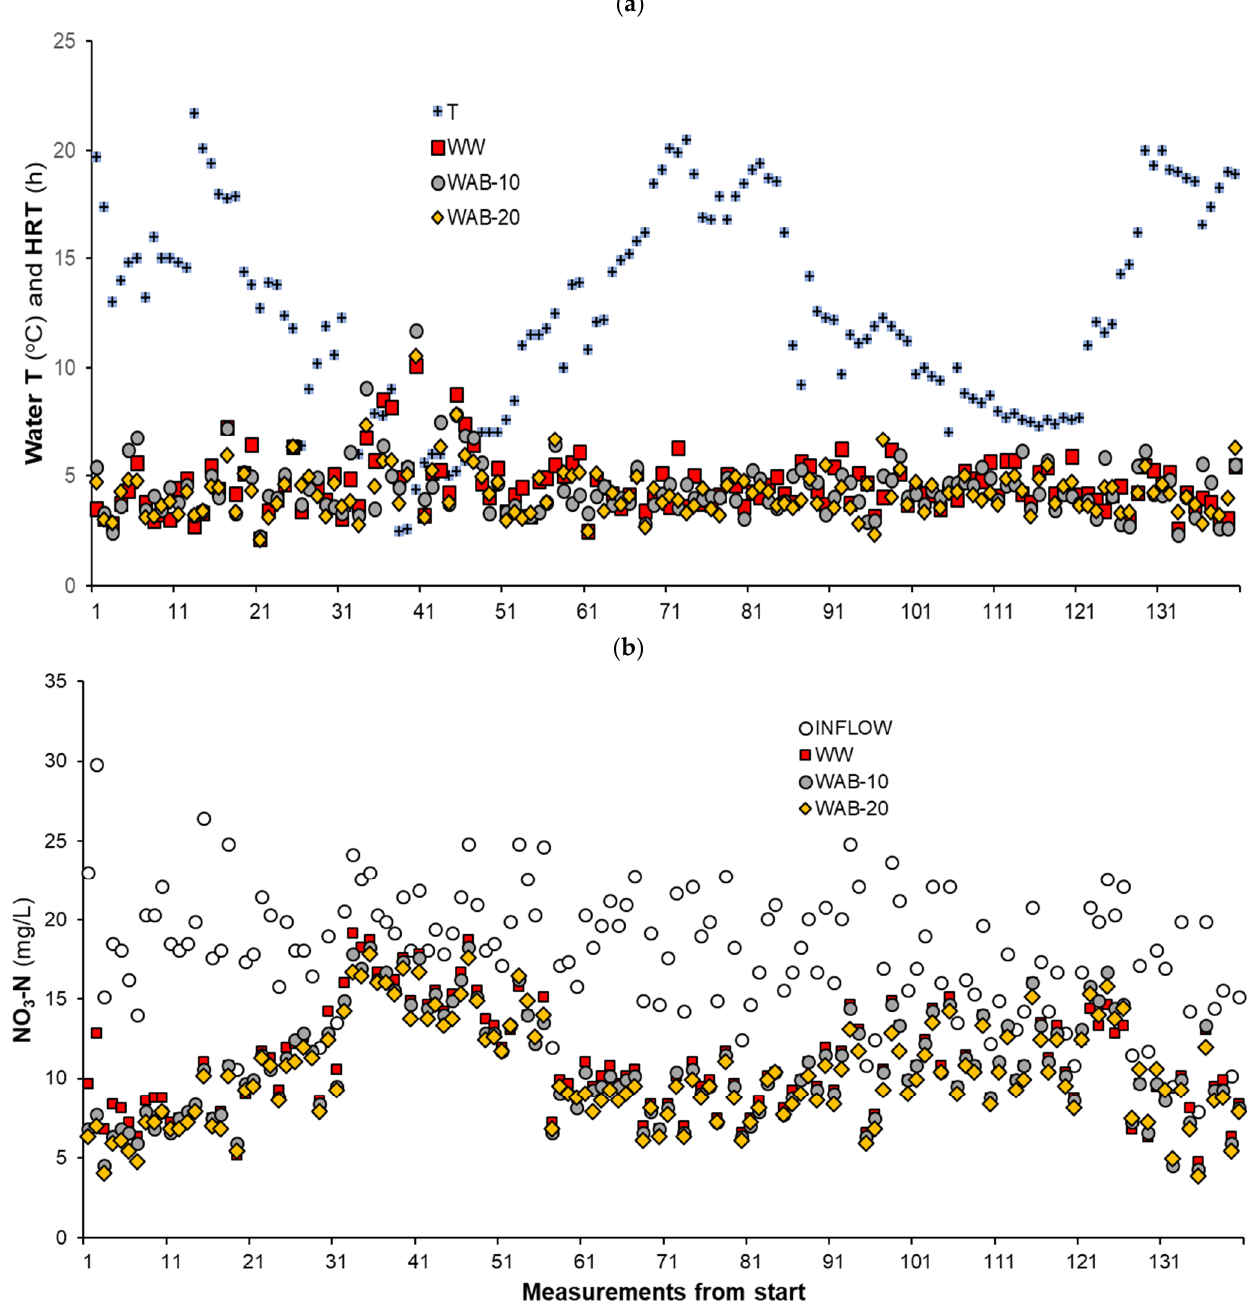
Figure 3. Inflow water T ( ◦ C) and HRT ( a ), and NO 3 -N concentrations at the inlet and outlet ( b ) of WW, WAB-10, and WAB-20 bioreactors. The inceptive cases are neglected in the graphs.